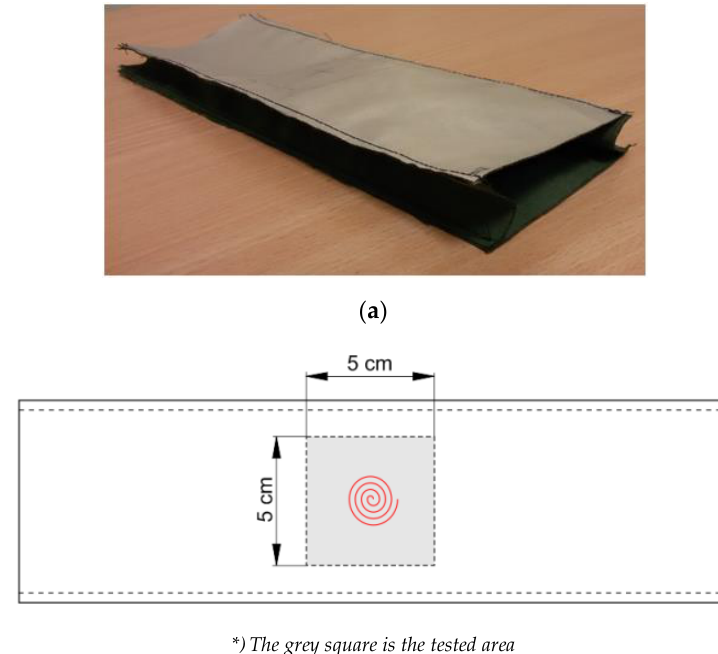
Figure 6. The sample of smart textile materials with SMA elements for the test of resistance to radiant heat: ( a ) a photo and ( b ) a scheme.